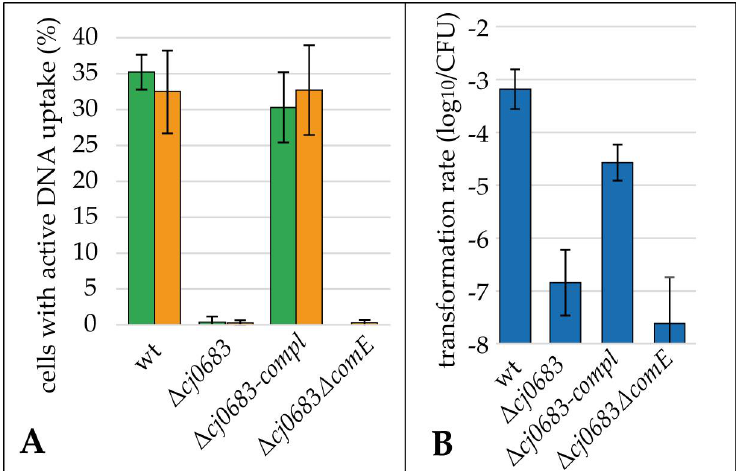
Figure 6. Cj0683 plays a pivotal role for DNA uptake into the periplasm of C. jejuni . DNA uptake ( A ) and transformation rate ( B ) in 81–176 (wt) and the mutant strains Δ cj0683, Δ cj0683-compl and Δ cj0683 Δ comE . ( A ) Cells were either incubated with fluorescein- (green bars, except for Δ cj0683 Δ comE ) or Cy3-labelled (orange bars) genomic DNA of 81–176 for 30 min. ( B ) Transformation rate was determined using unlabeled genomic DNA containing streptomycin resistance. Error bars indicate standard deviation ( n ≥ 4).